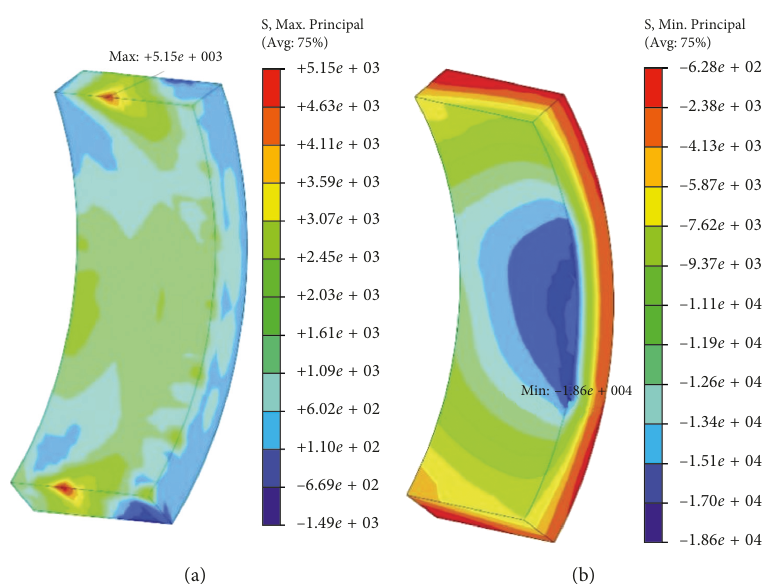
Figure 20: Maximum tensile and compressive stress of the segment with reinforcement depth of H (b) Maximum compressive